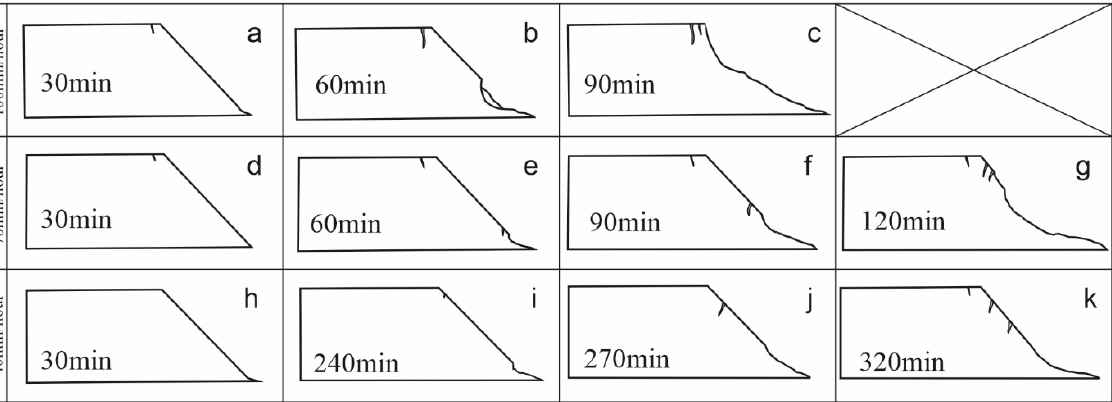
Figure 5. Slope failure patterns associated with different rainfall intensities: 100 mm/h ( a , b , c ), 70 mm/h ( d , e , f , g ) and 40 mm/h ( h , i , j , k ). Explanation is provided in the text.